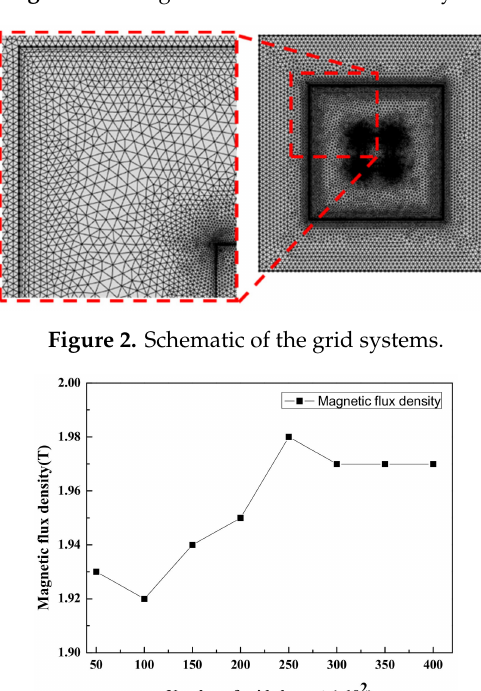
Figure 1. Configurations for numerical analysis.